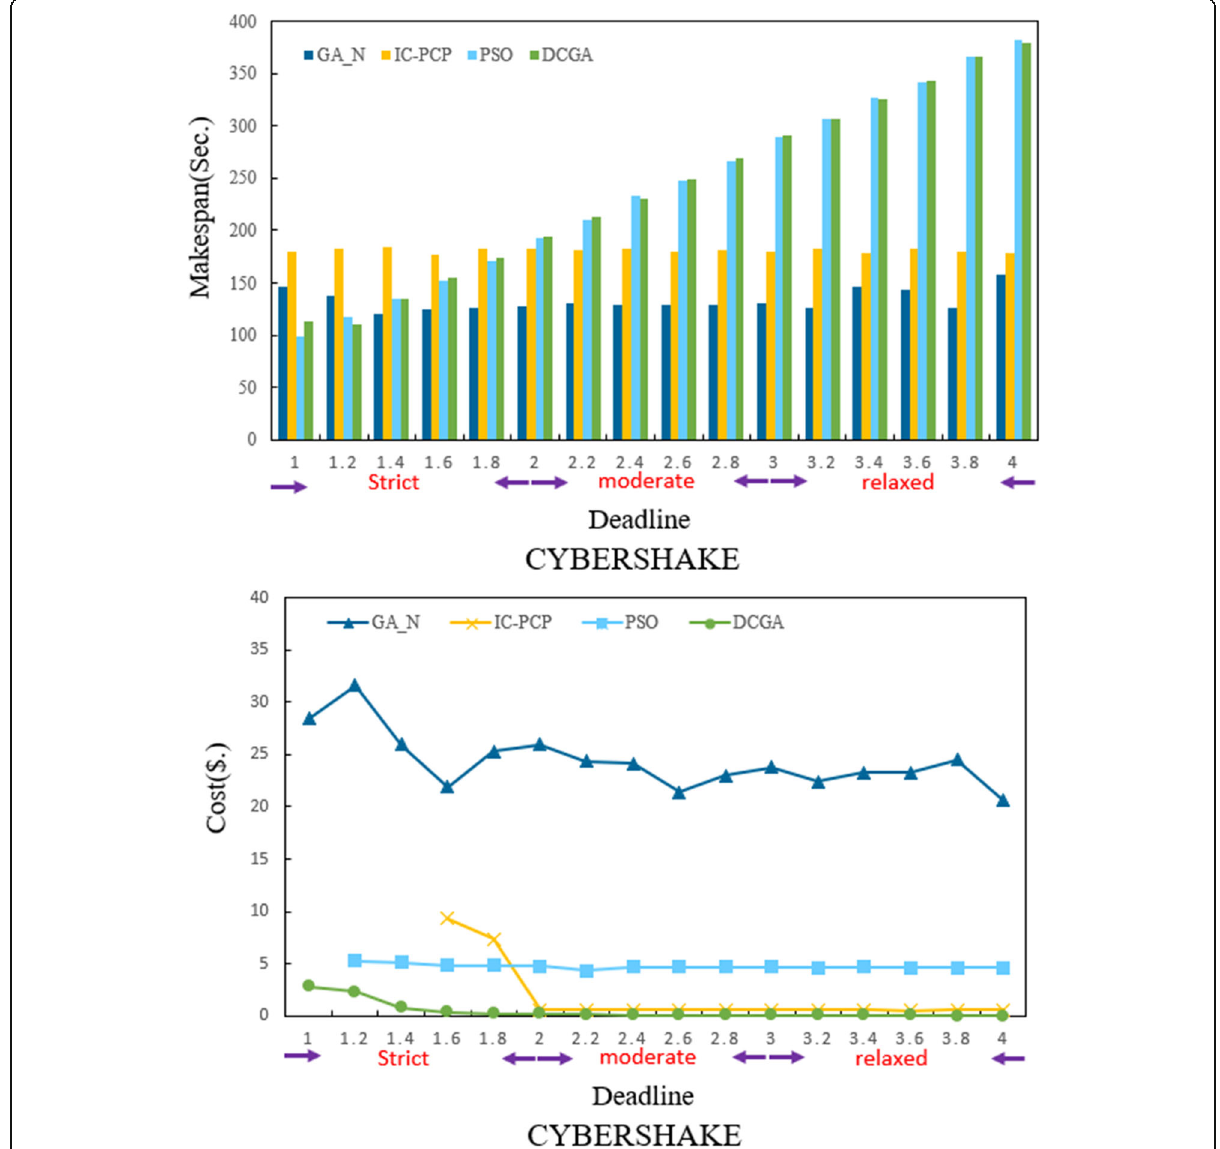
Fig. 9 Makespan and cost of scheduling on Cybershake under different deadline